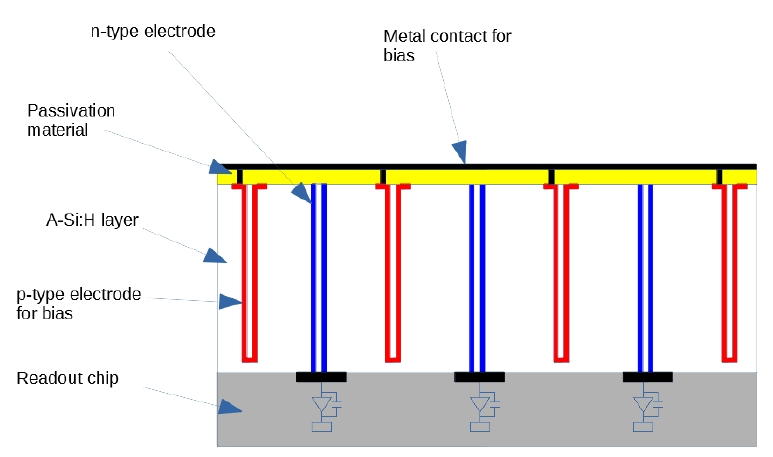
Figure 14. 3D a-Si:H detector deposited on a readout chip. N-type electrodes are connected directly on the readout pad of the chip, whereas p-type electrodes are connected to a common biasing plane.